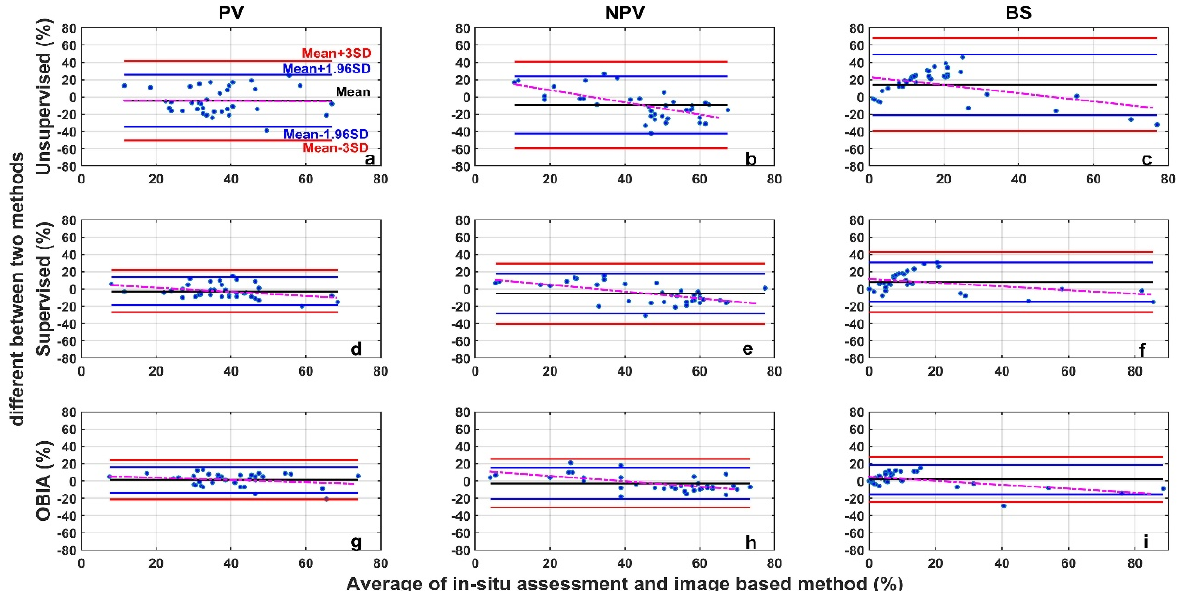
Figure 8. Bland-Altman plot of the difference between image analysis methods (unsupervised ( a – c ), supervised ( d – f ), and OBIA ( g – i )) and in situ assessment for PV ( a , d , g ), NPV ( b , e , h ), and BS ( c , f , i ) fraction covers. Refer to the top-left panel for threshold values. The red dotted line is the regression between the two-method mean and the two-method